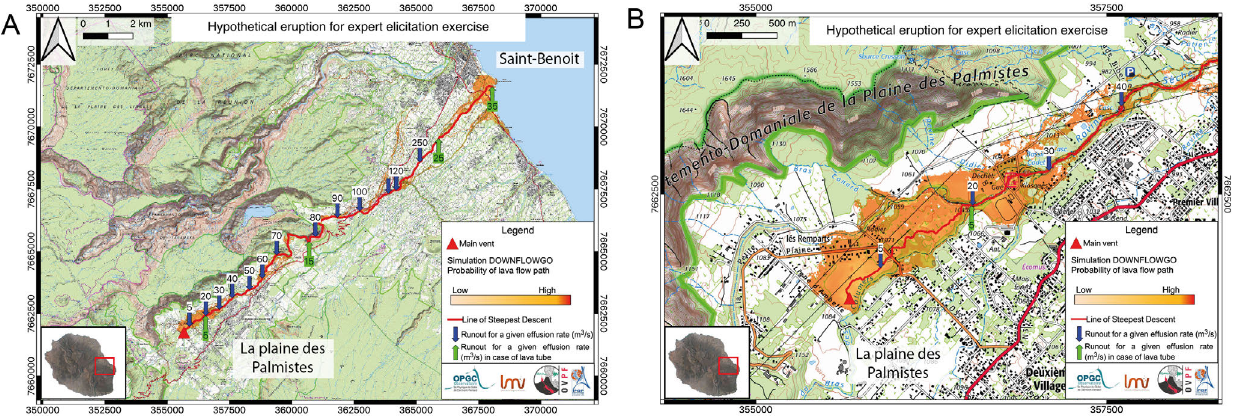
Figure 7: [A] First map that would have been produced for the hypothetical scenario of a fissure opening in La Plaine des Palmistes. This map shows the runout distance for a given discharge rate in the case of an open channel system (as usu- ally first assumed, in blue) and in the case formation of a tube system (in green). [B] Zoom of the map to identify proximal buildings and roads that will be the first to be at